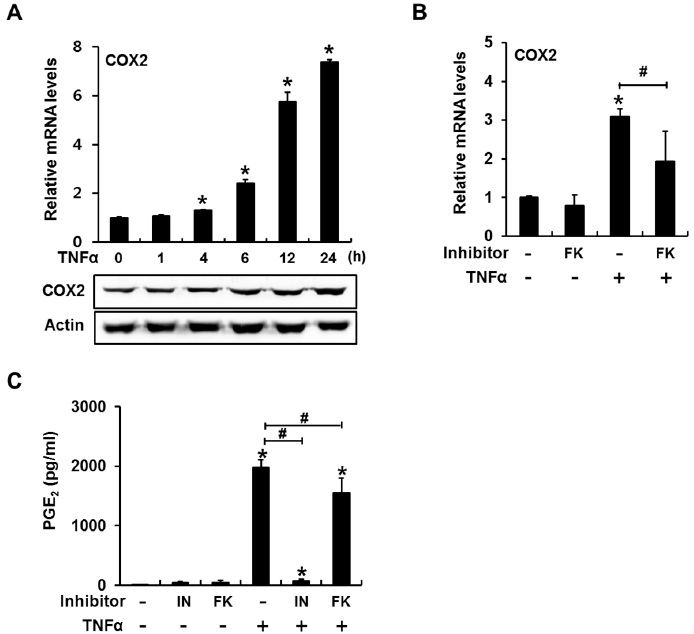
Figure 2. The calcineurin/NFAT signaling pathway mediates TNF α -induced cyclooxygenase 2 (COX2) expression and prostaglandin E2 (PGE 2 ) production in C2C12 cells. ( A ) TNF α stimulated COX2 mRNA and protein expression in a time-dependent manner; ( B ) TNF α -mediated COX2 expression decreased following inhibition of the calcineurin/NFAT signaling pathway. C2C12 cells pretreated with the calcineurin phosphatase inhibitor FK506 (10 μ g/mL) were incubated in the presence or absence of TNF α for 24 h and subjected to RT-PCR analyses; ( C ) TNF α -induced PGE 2 production was blocked by indomethacin, a COX inhibitor. Treatment with FK506 slightly suppressed TNF α -induced PGE 2 production. C2C12 cells were incubated with FK506 or indomethacin (20 µ M) in the presence of TNF α for 24 h and subjected to a PGE 2 parameter assay (* p < 0.05, compared to control; # p < 0.05).